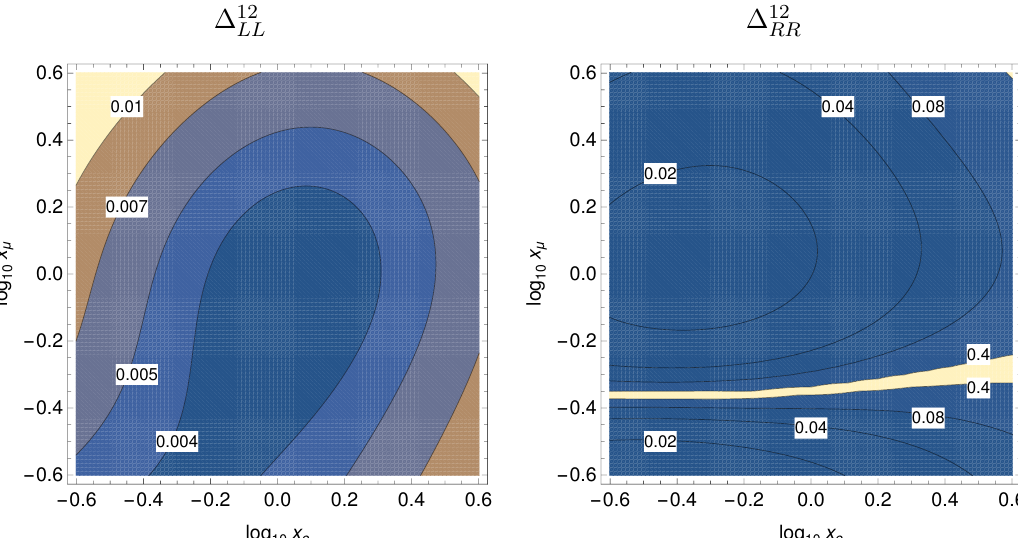
Figure 9 . Upper bounds on the (cid:13)avour violating LL and RR parameters using the current experi- mental limit on Br( (cid:22) ! e(cid:13) ) for tan (cid:12) = 2 and M = 800 GeV as a function of splitting between the masses of gaugino and sleptons of various (cid:13)avours. The normalised selectron and smuon masses, x e ( (cid:22) ) = m ~ e (~ (cid:22) ) =M are plotted on the